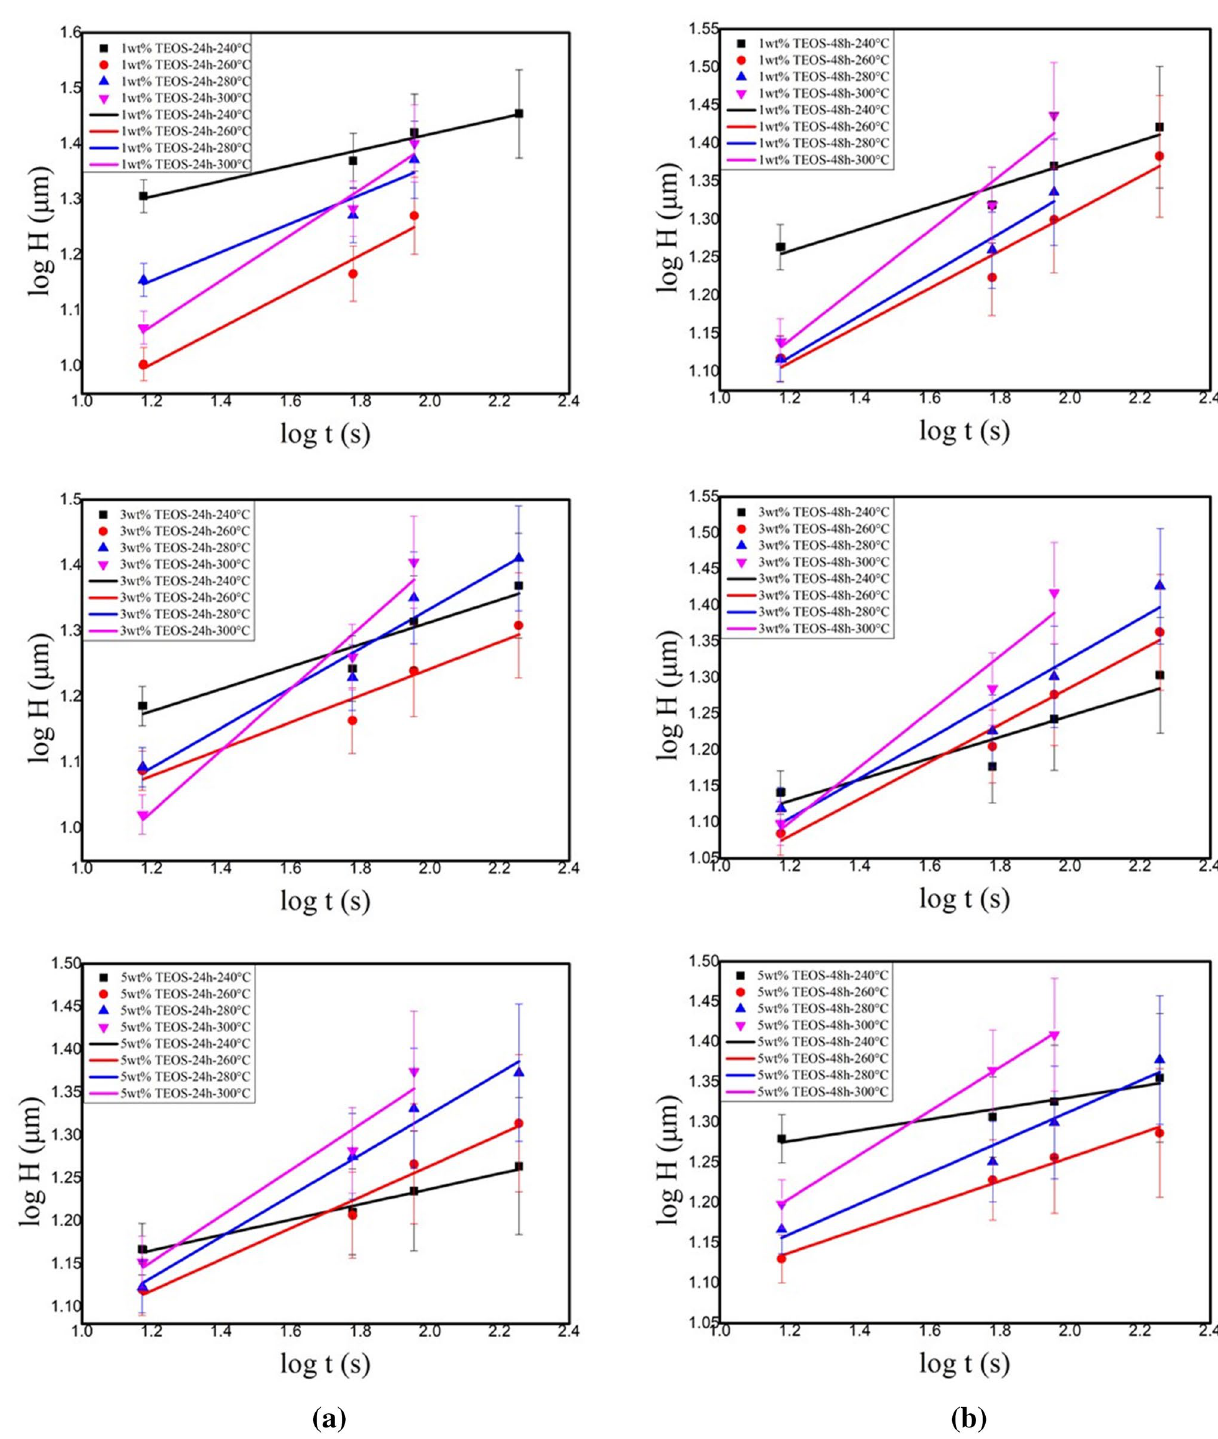
Fig. 9 Plots of log H versus logt for samples after reaction for (a) 24 h and (b) 48